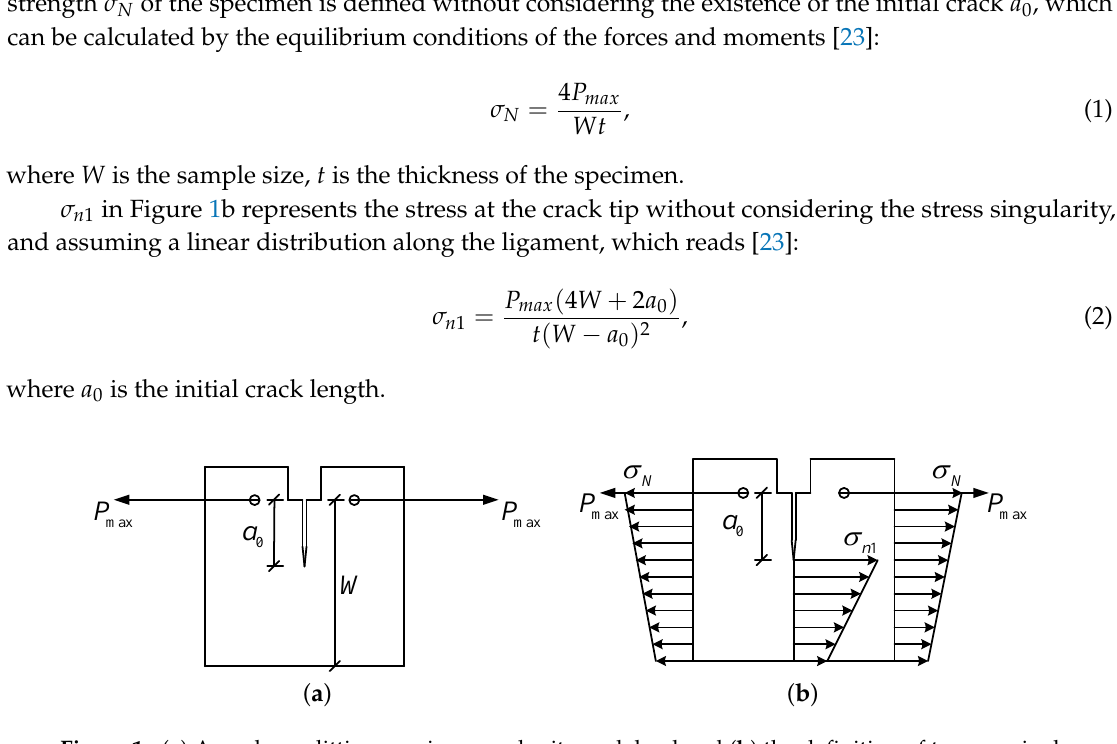
Figure 1. ( a ) A wedge-splitting specimen under its peak load and ( b ) the definition of two nominal stresses in Hu-Duan’s boundary effect